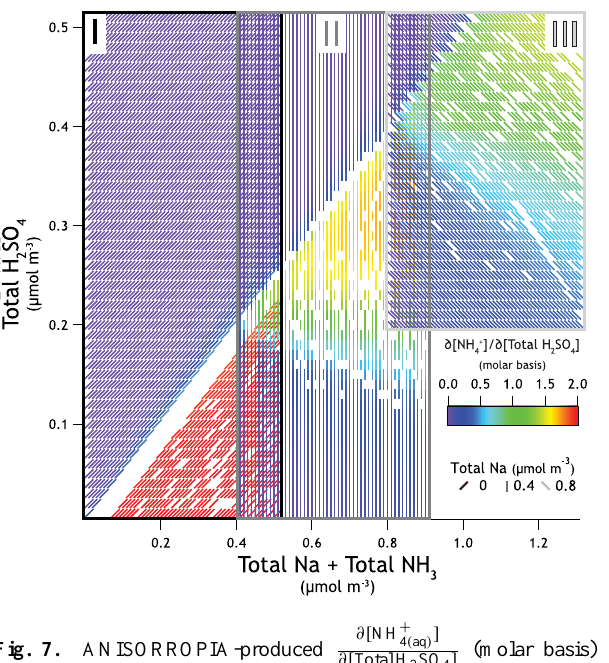
] ∂ [ NH + 4 ( aq ) Fig. 7. ANISORROPIA-produced (molar basis) ∂ [ TotalH 2 SO 4 ] for the NH + -SO 2 − -HSO − -NO − -Na + -Cl − -H 2 O aerosol system 4 4 4 3 at a RH of 40% and a temperature of 300K. The total HCl is 0.8µmolm − 3 , and the total HNO 3 is 0.01µmolm − 3 . Region I cor- responds to 0µmolm − 3 of total Na, Region II to 0.4µmol m − 3 of total Na, and Region III to 0.8µmolm − 3 of total Na. Note the transition in sensitivity at a ratio of 2 moles of positive ions (total NH 3 +Na) to 1 mole of total H 2 SO 4 ( R S = 2). The increasing gra- dient from left to right in Regions II and III demonstrates the contri- bution of positive ions from Na + initially balancing SO 2 − (i.e., ( aq ) 4 ( aq ) ] ∂ [ NH + 4 ( aq ) low ) and the increasing contribution of NH + to ∂ [ TotalH 2 SO 4 ] 4 ( aq ) the charge balance with more negative ions present.